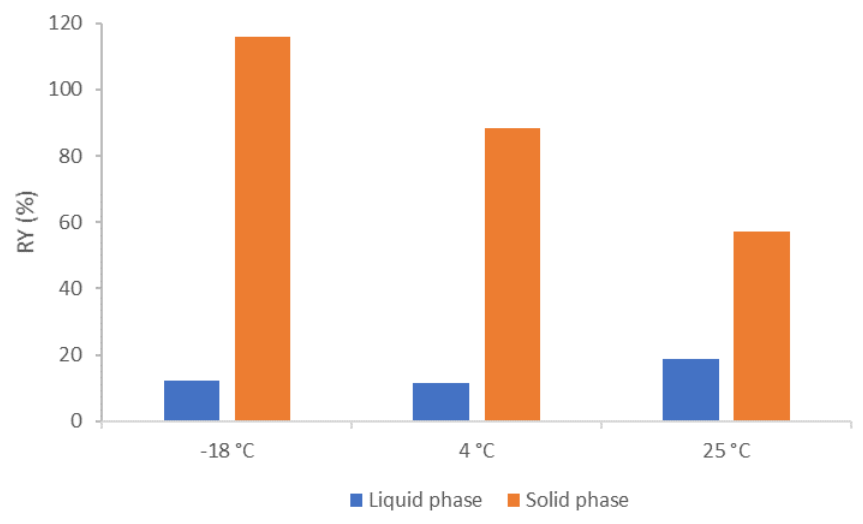
Figure 4. EE fractions recovery yields (RY).